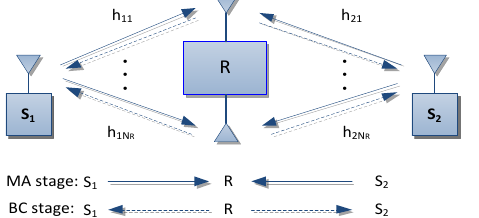
Fig.1 Two-way relaying channel with multiple